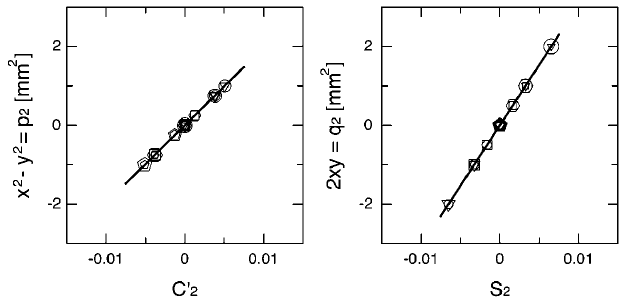
FIG. 14. Relation between p merically calculated BPM with elliptical cross section.